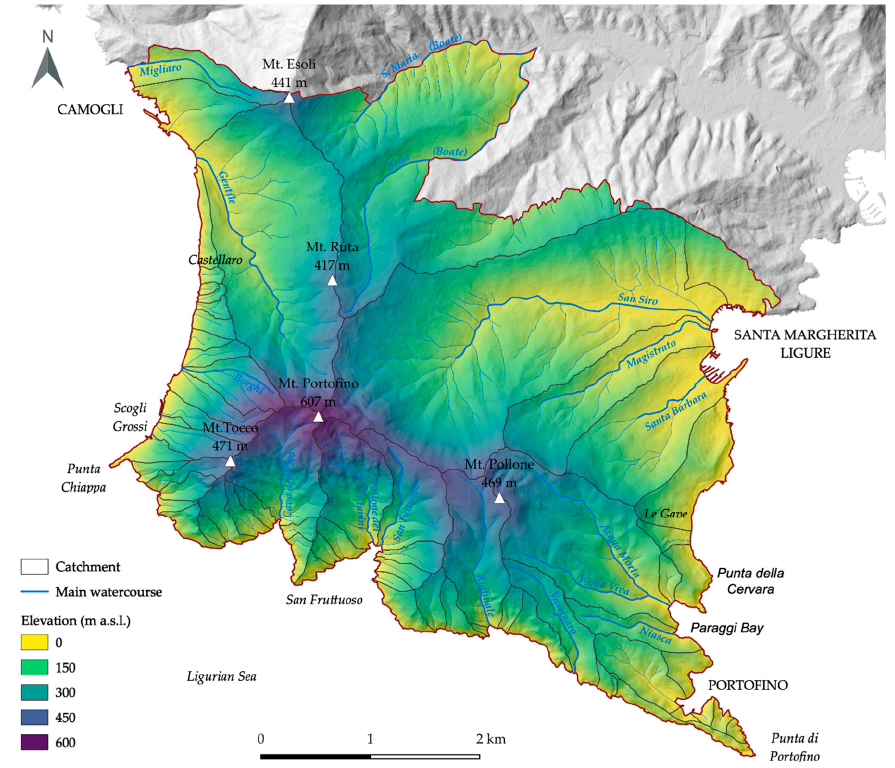
Figure 2. Geographical setting of the Portofino promontory.